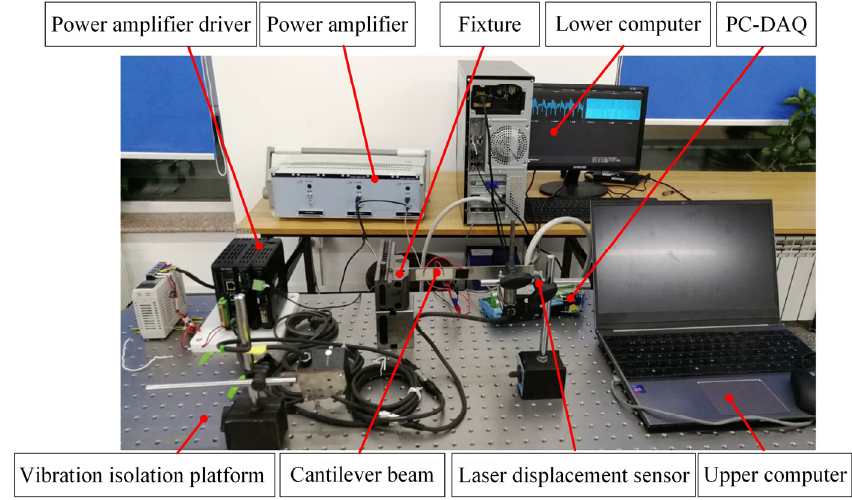
Figure 8. System identification experimental platform.